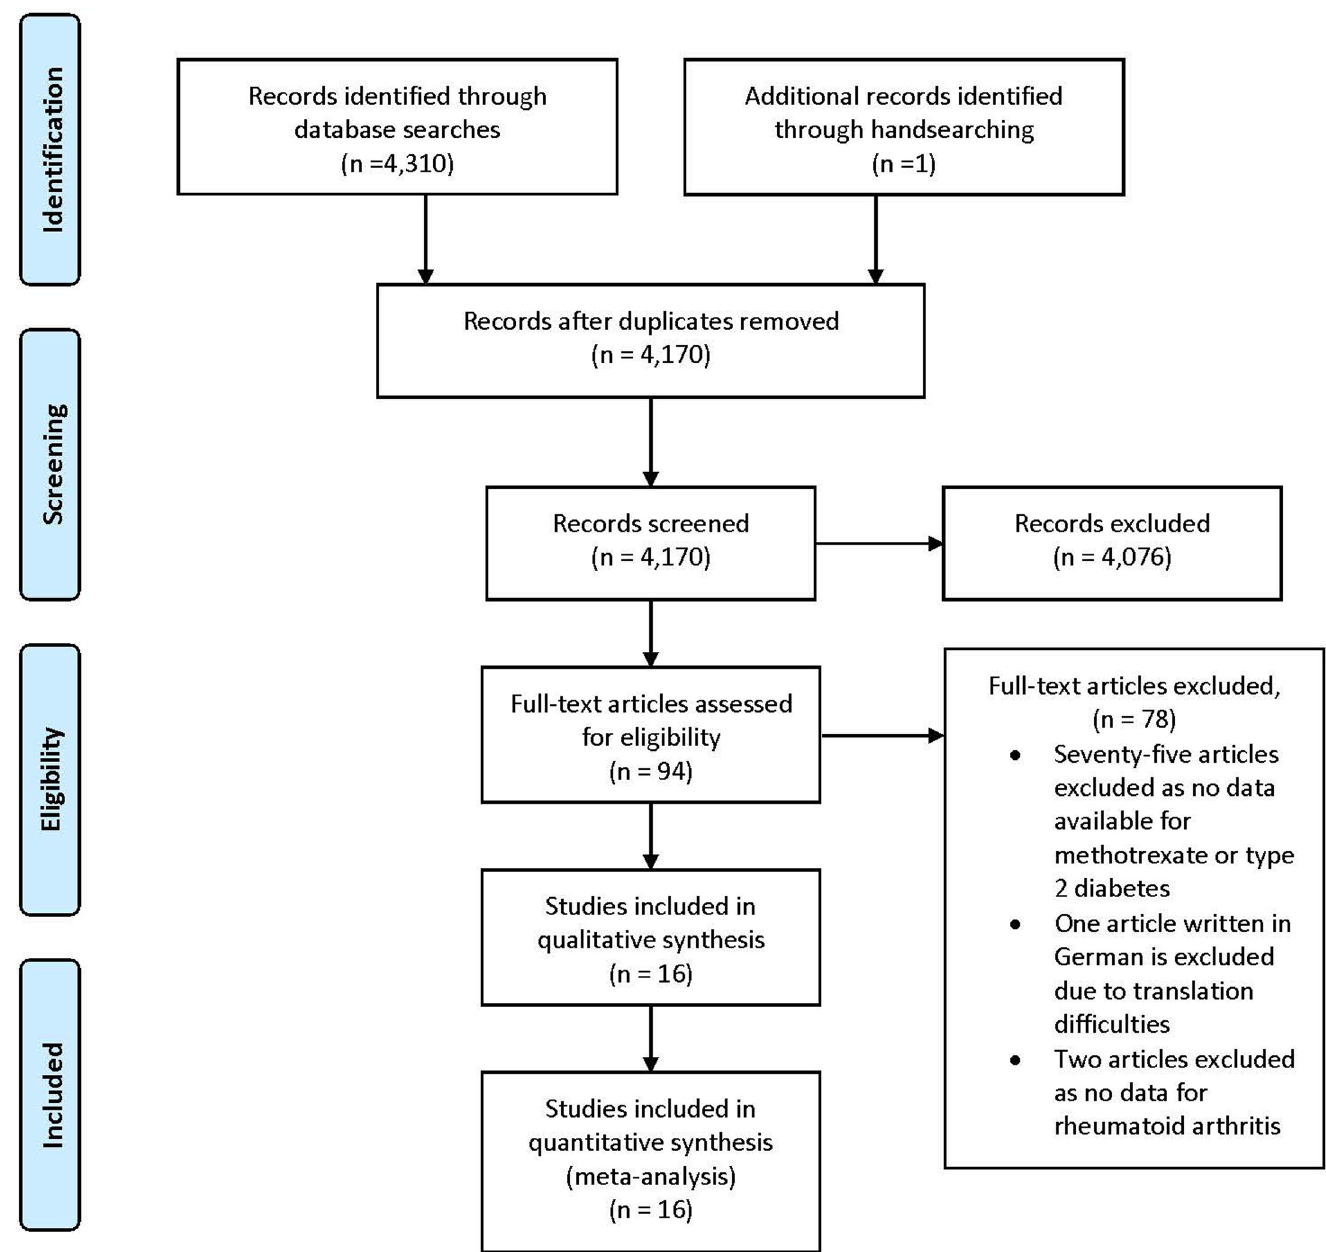
Fig 1. Flow diagram of the studies eligible for the review and